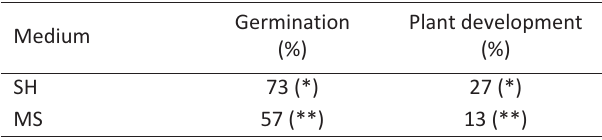
Table 1 ­ Effect of medium culture on germination and plant development of Cycas revoluta